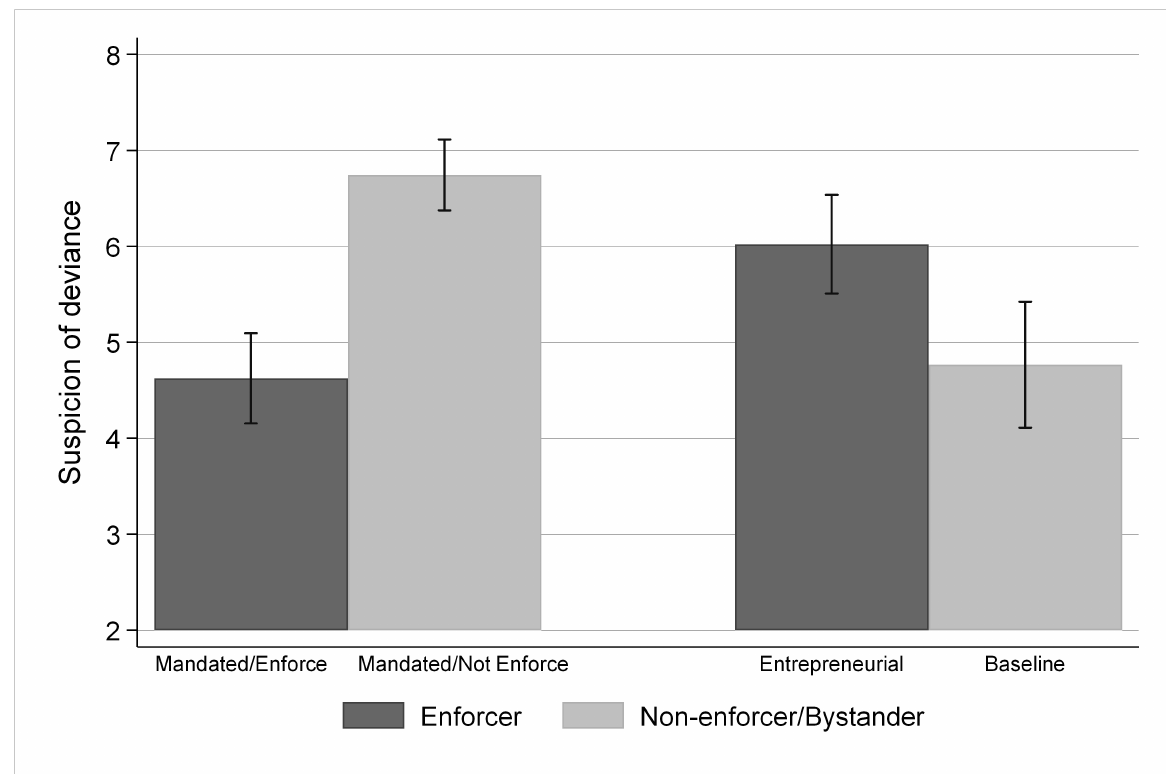
Figure 1: Between-subject comparison of perceived likelihood that student 6 changed his response in study 1. The error bars indicate the 95 percent confidence interval. Possible values of the y axis range from 1 (very unlikely) to 10 (very likely). The measure is the response to the question, “How likely is it that student